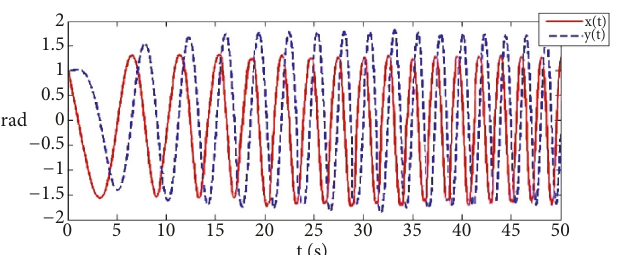
Figure 13: CPG output signal.